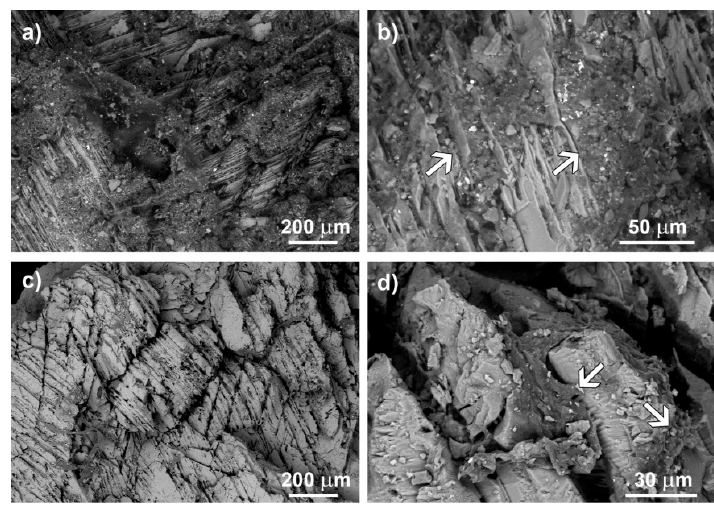
Figure 3. Environmental scanning electron microscopy (ESEM) micrographs of the untreated ( a , b ) and treated ( c , d ) stone substrate. The arrows indicate the extensive colonization covering the mineral substrate ( b ) and the residual presence of the biofilm ( d ) after the treatment.